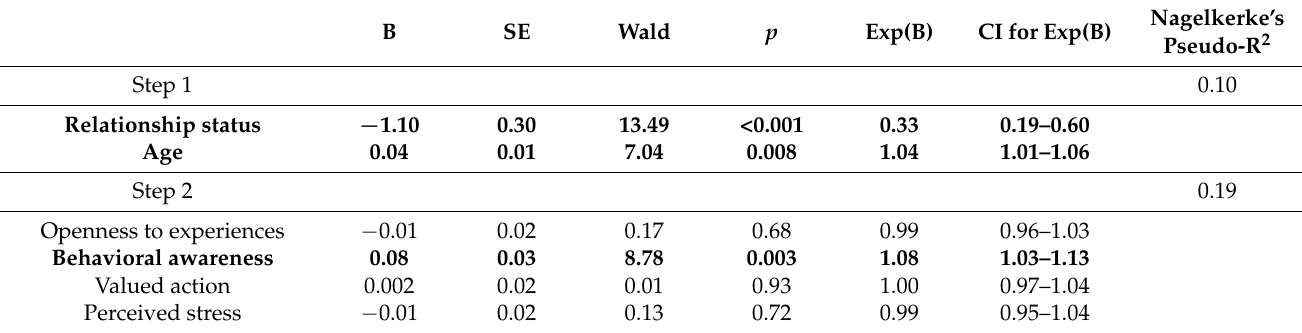
Table 3. Limiting close contacts adherence, as predicted by psychological flexibility components and perceived